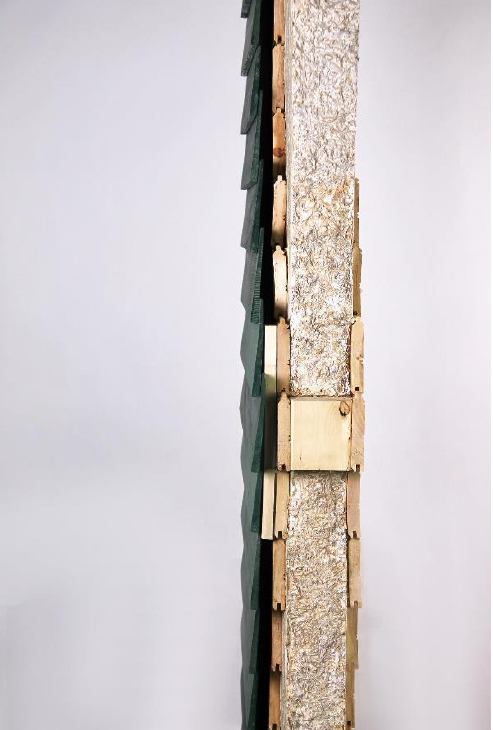
Figure 4. Mycelium-based composite. (Source: Courtesy of Ecovative) .